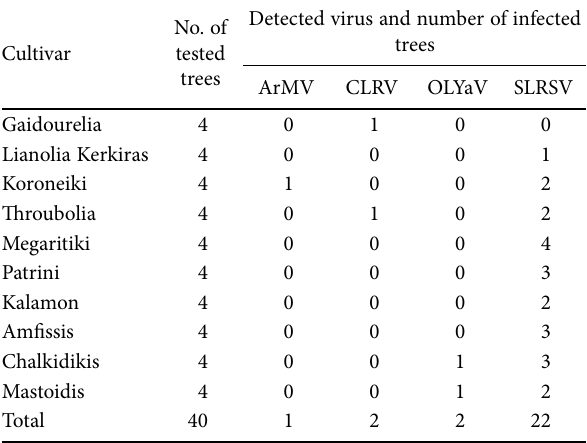
Table 1. Sampled Greek olive cultivars, and results of the molecular detection of ArMV, CLRV, OLYaV and SLRSV.